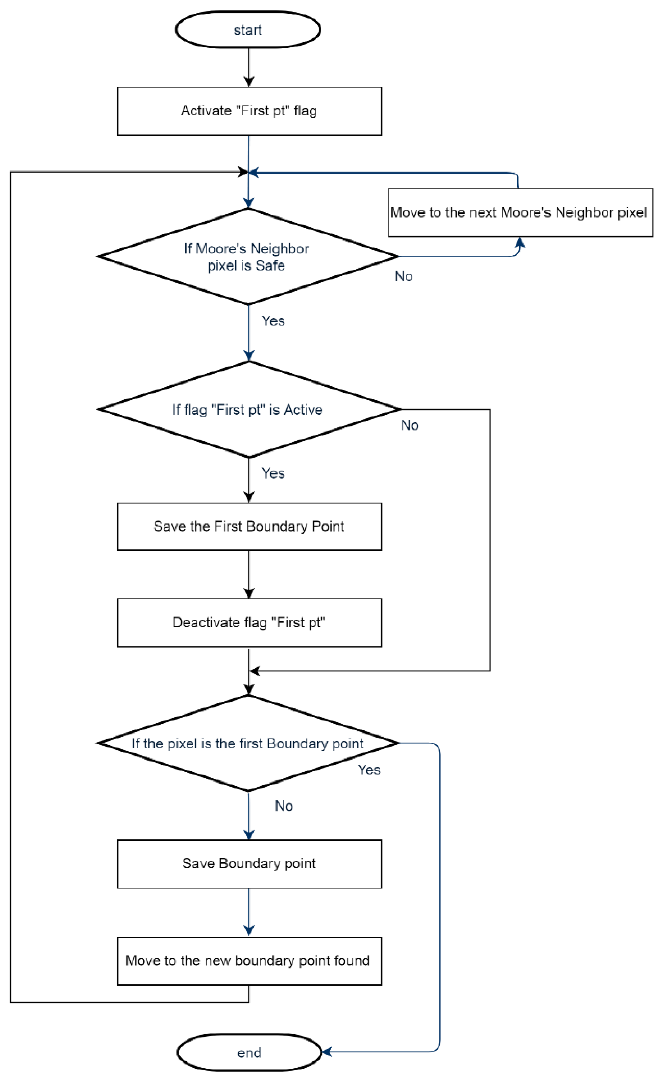
Figure 4. Boundary points’ detection Flowchart. Table 1. Moore-neighbor vector ( 𝑁 (cid:3040) ). i is the index of the neighbor pixel (0 to 7) total 8. 0 is the relative shift in the x-axis, and 1 is the relative shift in the y-direction.